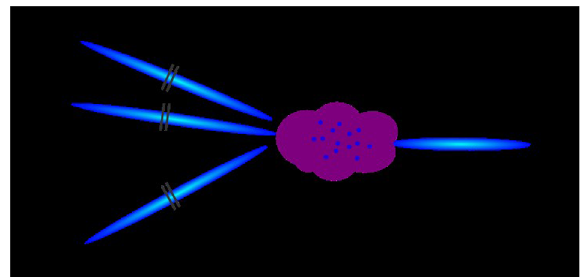
Fig. 3 Four-wave mixing scheme. Inset I in Fig. 1 is shown for a four-wave mixing process. Three incoming waves k 1 , k 2 , k 3 interact with matter. The fourth k s mode is the detected signal in the direction dictated by the phase- matching factor f ( Δ k ) introduced in Eq.